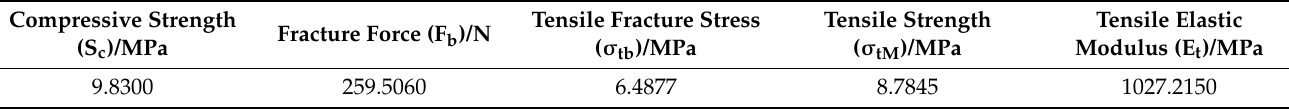
Figure 11. Tensile curve of a 3D-printed specimen. Table 5. Data of the quasi-static mechanical properties of a 3D-printed